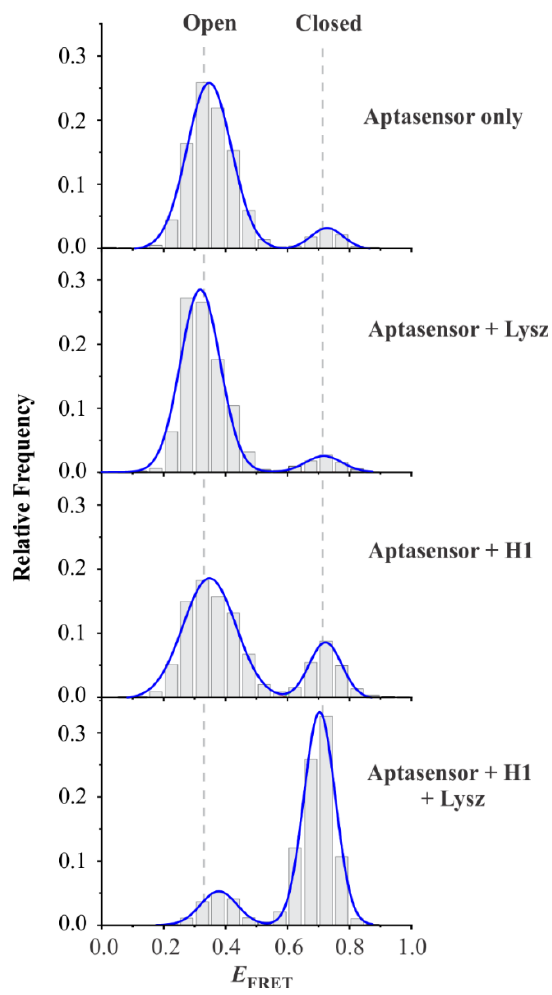
Figure 3. Lysozyme sensing. FRET efficiency histograms of “ Aptasensor ” , “ Aptasensor + lysozyme ” , “ aptasensor + H1”, and “ aptasensor + H1 + Lysozyme ” , respectively (from top to bottom). The term “ Lysz ” represents lysozyme. The concentration of aptasensor, H1, and lysozyme used were 20 pM, 1 µM, and 2 µM, respectively. The data show that both lysozyme and H1 are required for high-FRET signal. Each histogram is prepared from more than 100 molecules.